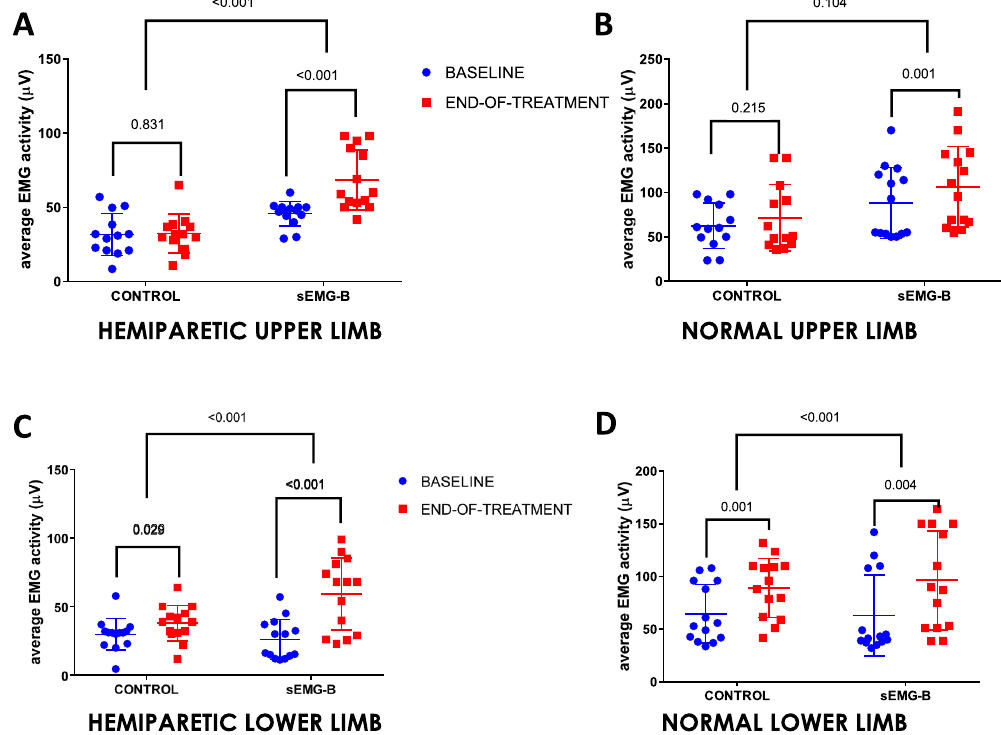
Figure 2. Box-plots with individual activity showing changes in average EMG activity in the hemiparetic and normal extremities. Muscular activity was expressed as the % of the maximum voluntary isometric contraction (%MVIC). Statistically significance values were determined through the ANCOVA analysis. Precise data and statistical significance values are available in Supplementary Table S2.